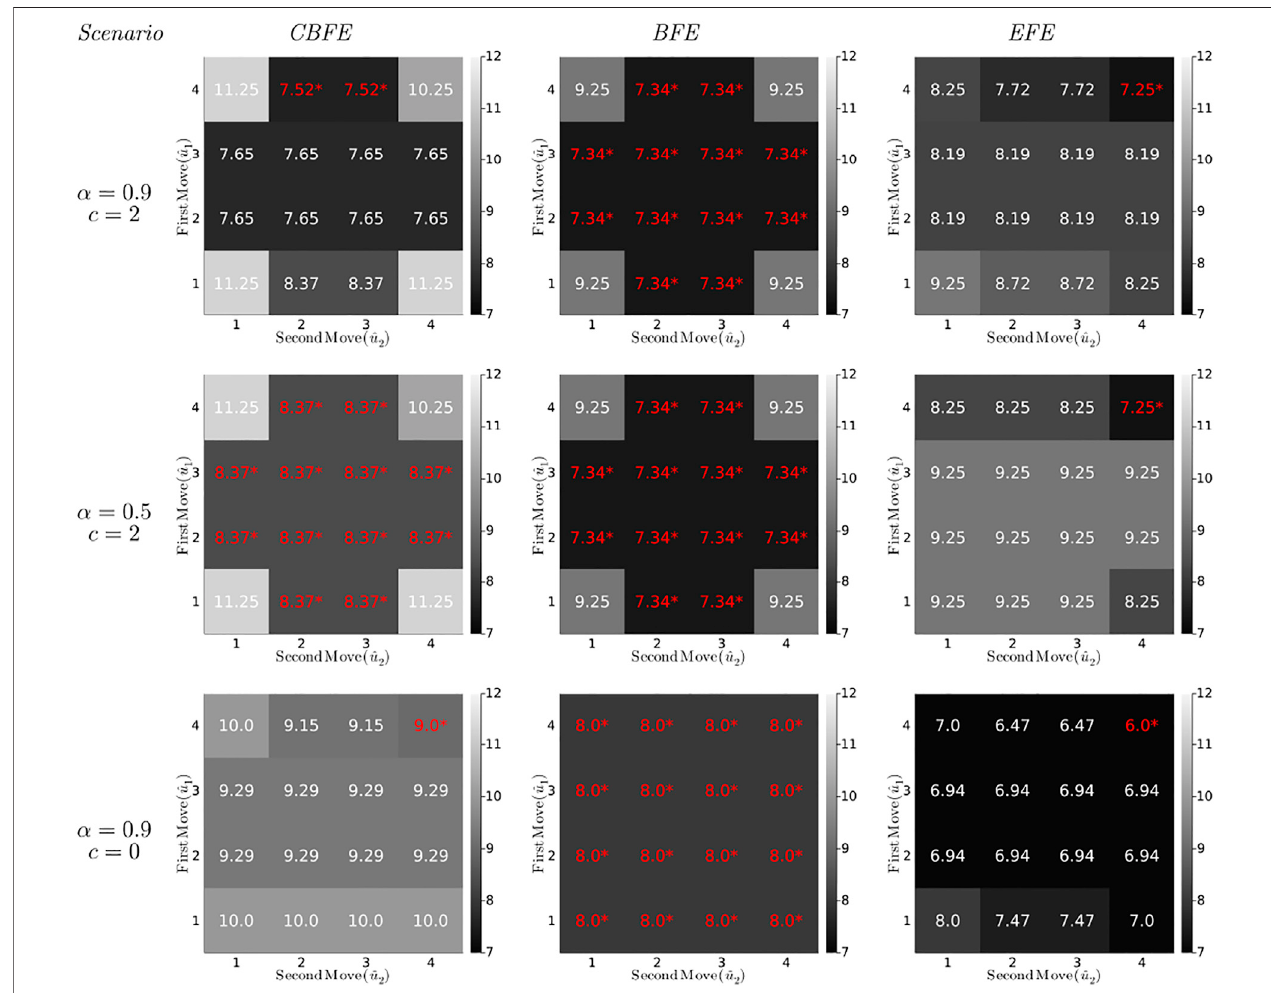
FIGURE 7 | (Constrained) Bethe Free Energies ((C)BFE) and Expected Free Energies (EFE) (in bits) for the T-maze policies under varying parameter settings. Each diagram plots the minimized free energy values for all possible policies (lookahead T = 2), with the fi rst move on the vertical axis and the second move on the horizontal axis.Forexample,thecellinrow4,column 3representsthepolicy ^ u (cid:2) ( 4 , 3 ) ,which fi rstmoves toposition4andthen toposition3.Thevaluesfortheoptimalpolicies ^ u * are annotated red with an